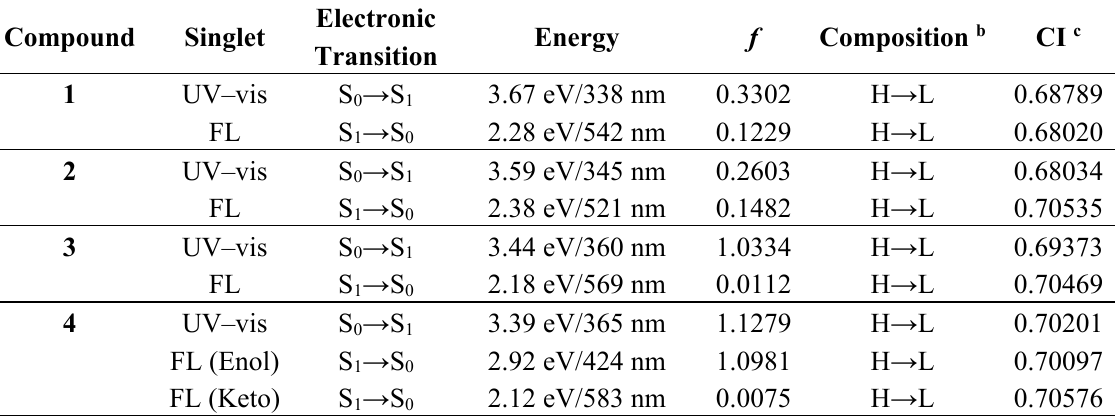
Table 5. Selected electronic excitation energies and corresponding oscillator strengths ( f ), main configurations, and CI coefficients of the low-lying electronically excited states of compounds 1 – 4 a .